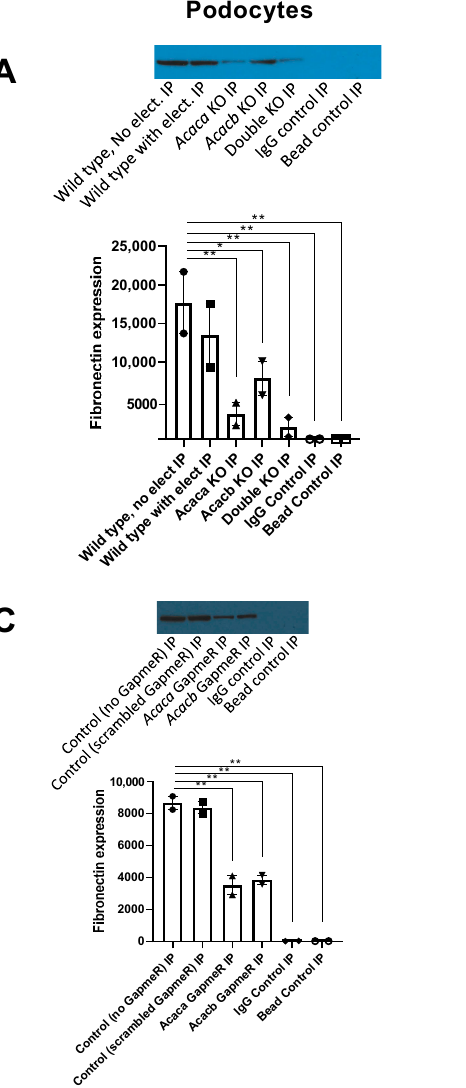
F Figure 7. Cont